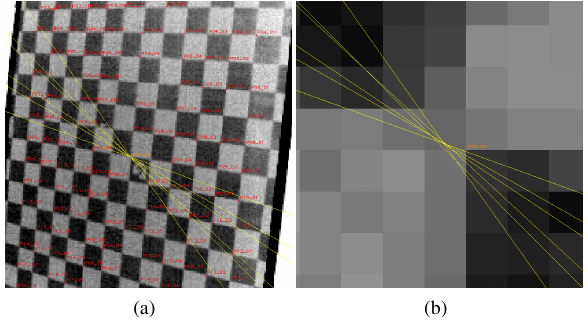
Figure 5. Epipolar geometry for one corner point seen in 7 images (a) LWIR image with detected chessboard corners (b) magnification for one point with sub-pixel accurate epipolar rays